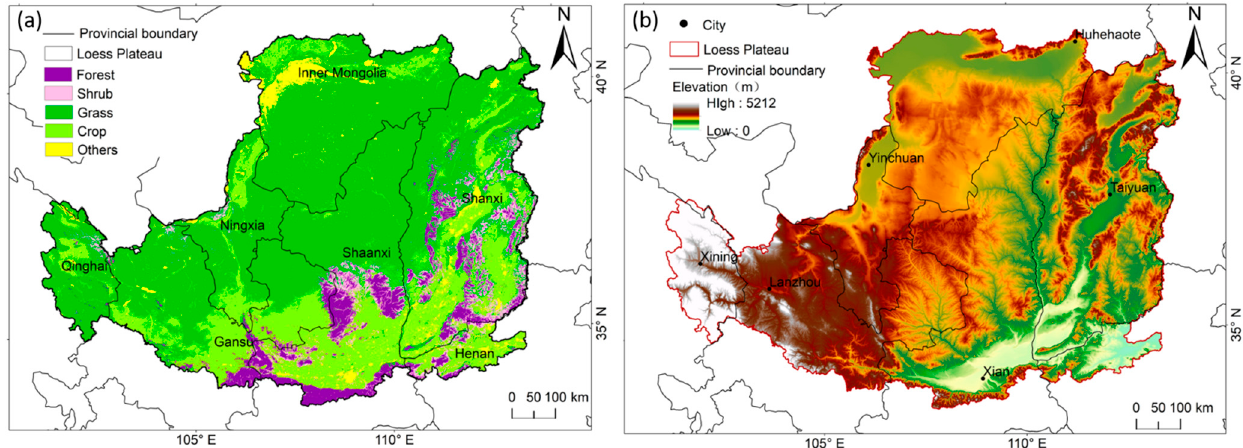
Figure 1. Study area: ( a ) Vegetation distribution and administrative countries of the CLP. ( b ) Eleva ‐ tion and provincial capital cities of the CLP. and provincial capital cities of the